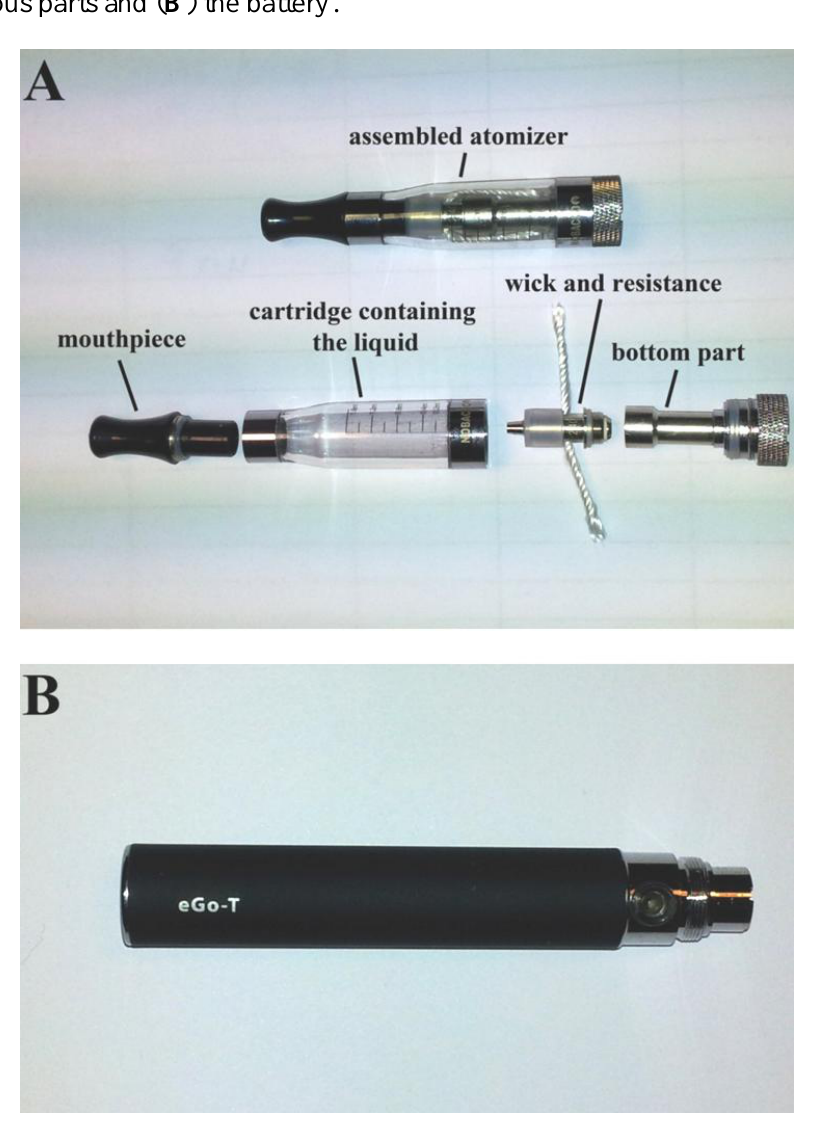
Figure 1. The electronic cigarette device used in the study, consisting of ( A ) the atomizer and its various parts and ( B ) the